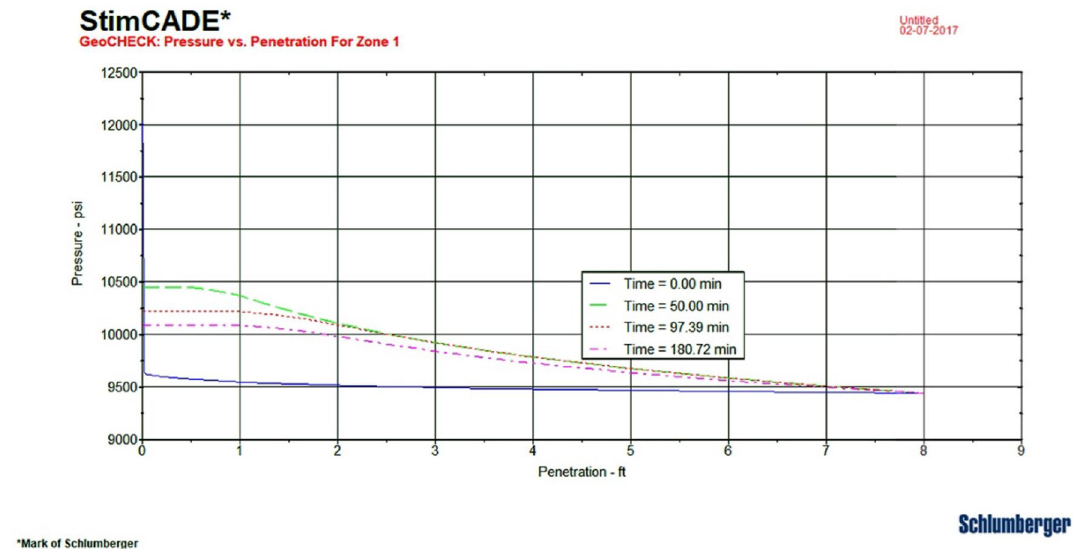
Fig. 10 Pressure differences versus acid penetration